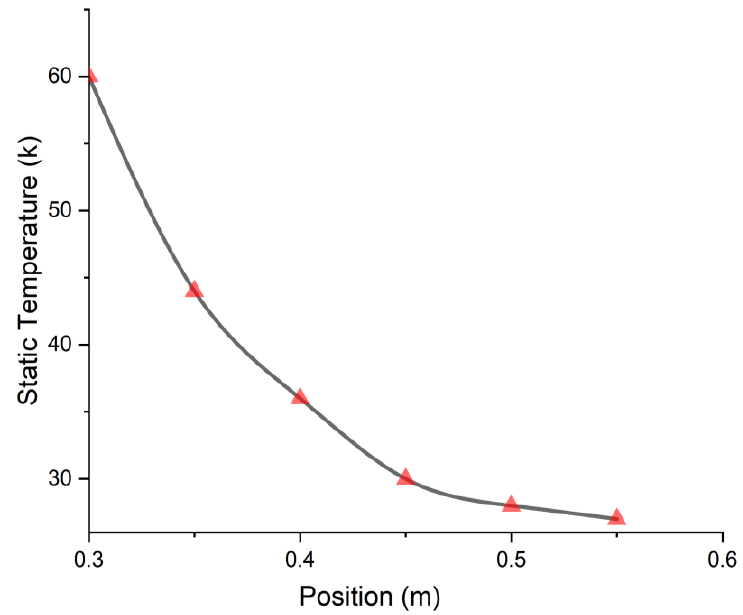
Figure 7. Distribution of temperature along the length of pulse tube for case 1.